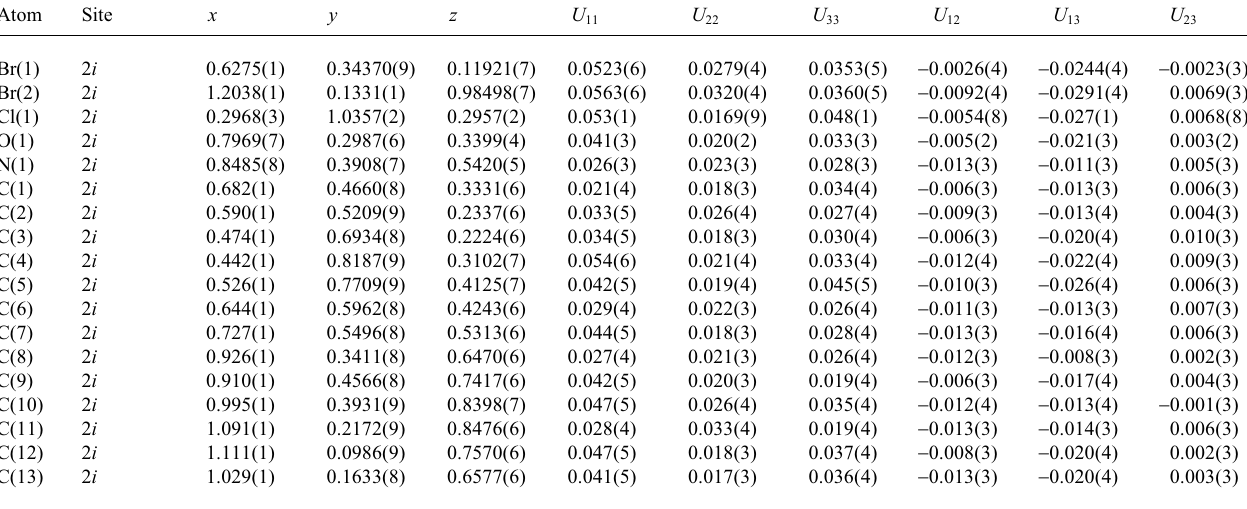
Table 3. Atomic coordinates and displacement parameters (in Å 2